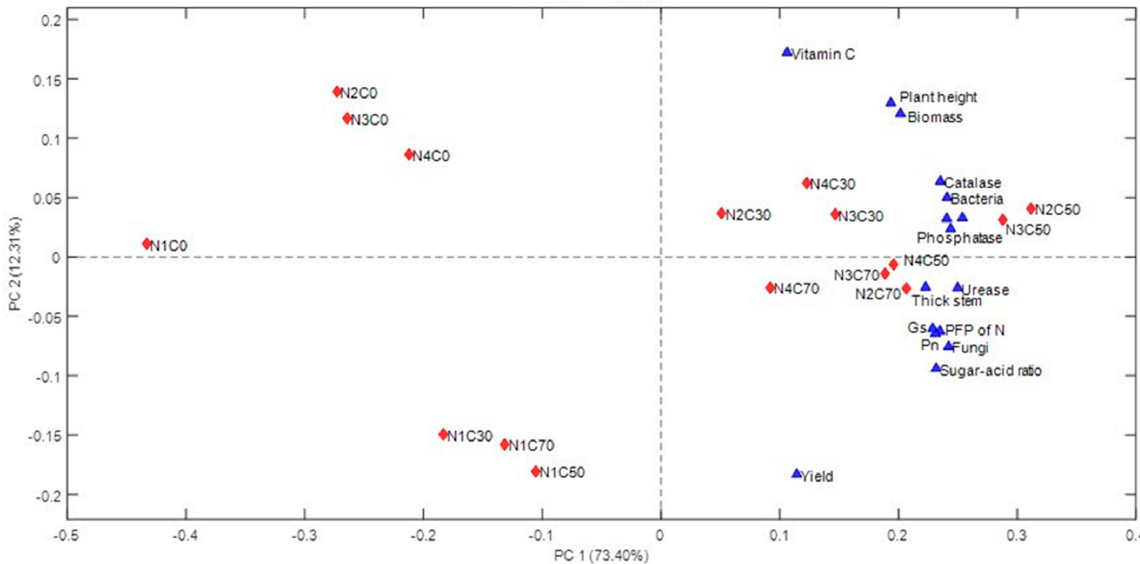
Figure 1. Principal component analysis (PCA) of all the measured soil ‒ plant parameters.